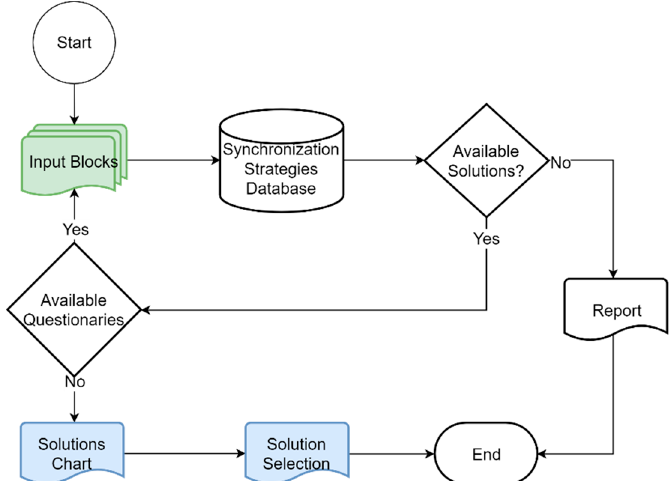
Figure 3. Flowchart of tools where all the input blocks are evaluated and queries to the time-synchronization strategies database are generated. The cycle ends when there is no solution available to fulfill the requirements or when all the input blocks are evaluated and the radar chart is generated.